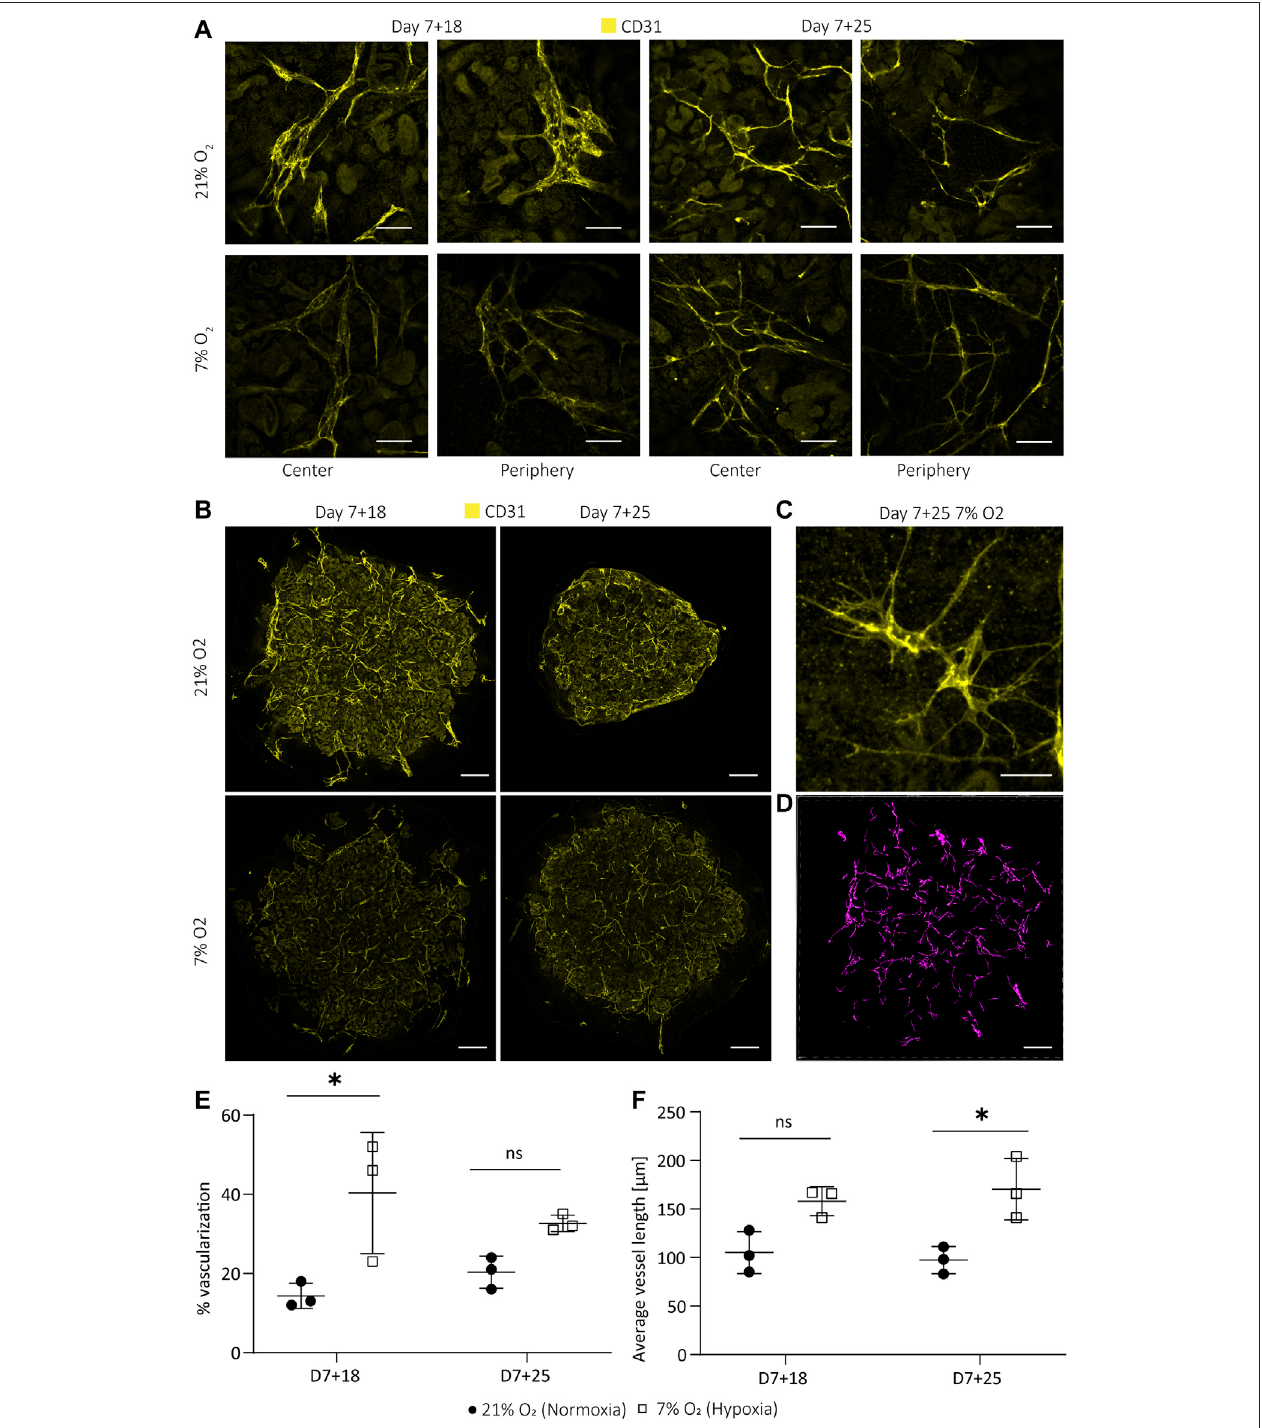
FIGURE6| Hypoxicorganoid culturepromotesinterconnectedmicrovasculatureformationandsprouting. (A) .Theendothelial network(CD31;yellow)hasamore homogeneous morphology and enhanced interconnectivity and branching in organoids cultured in 7% O 2 . (B) . Z-intensity projected images of whole mount imaged organoids show less intense CD31 staining, likely due to smaller vessel size. (C) . Hypoxia-induced sprouting of endothelial vessels at day 7 + 25. (D) . Example of 3D segmentationofendothelialnetworkofaday7+18normoxiaorganoid.Scalebars:50 µm (A,C) ;600 µm (B,D) .Quanti fi cation in3Dreveals (E) .anincreaseinthe volumefractionofendothelialcellsatday 7+18inhypoxiaand (F) .anincreasedaveragevessellengthinhypoxiacompared tonormoxiaatD7+25.( n =1, N =3).*= p ≤ 0.019.